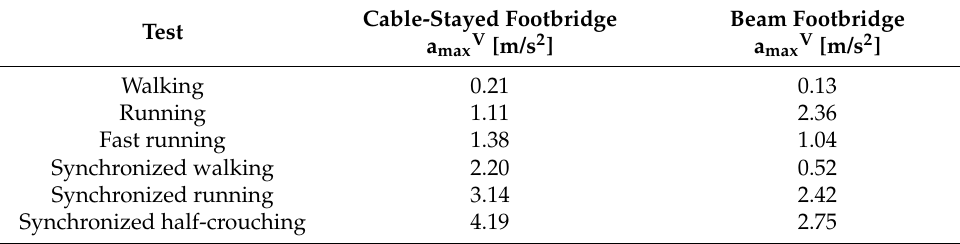
Table 8. Comparison of extreme accelerations of the deck.